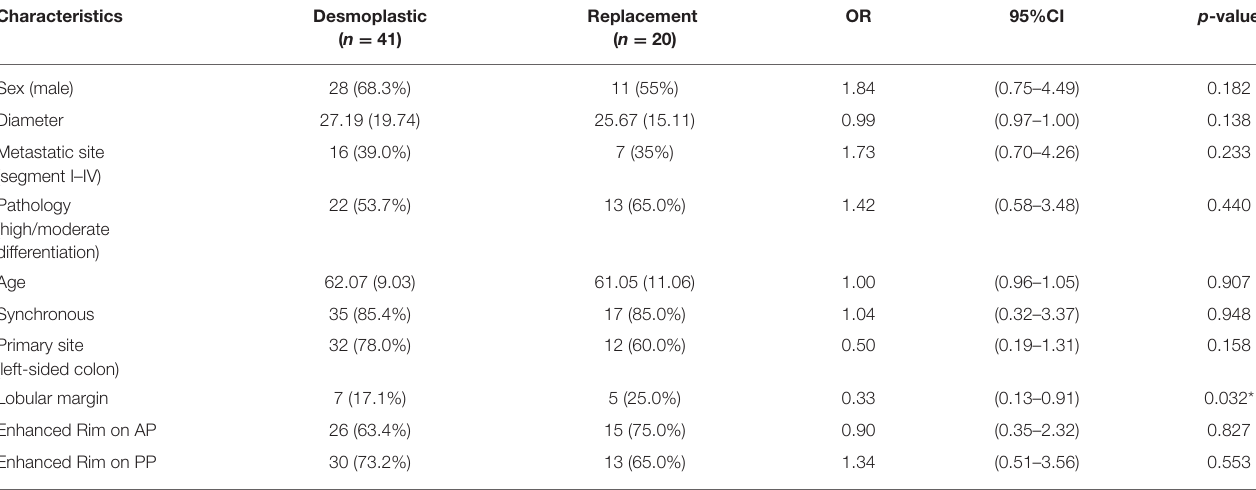
TABLE 2 | Univariate analysis of clinical and qualitative imaging features in distinguishing HGPs of CRLMs. Characteristics